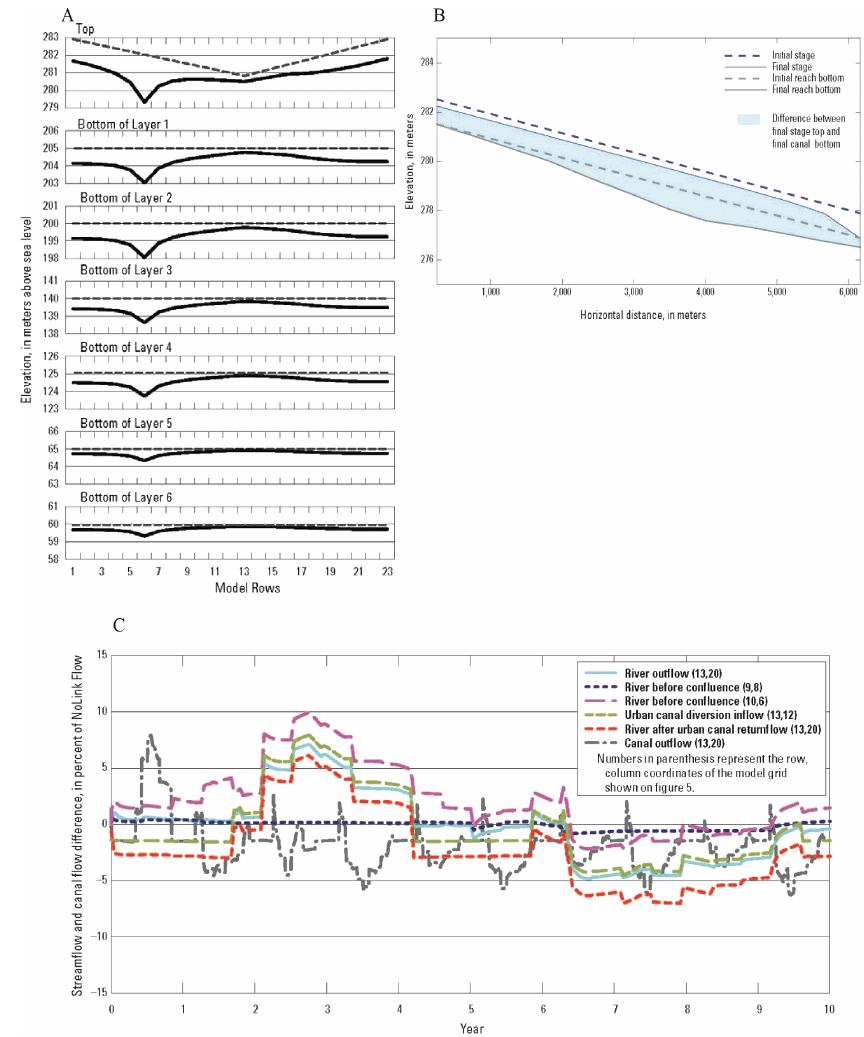
Figure 3. Example of simulated changes in bed altitudes (a) along model column 17 showing the final displacement of land surface and layer bottoms using SUB-Link (dashed line initial surface and solid line final surface), (b) with the deformable mesh using the Surface-water Routing Process of MF-OWHM along the urban canal, and (c) Difference in streamflow between using SUB-Link and using just SUB with no linkage (Schmid et al.,